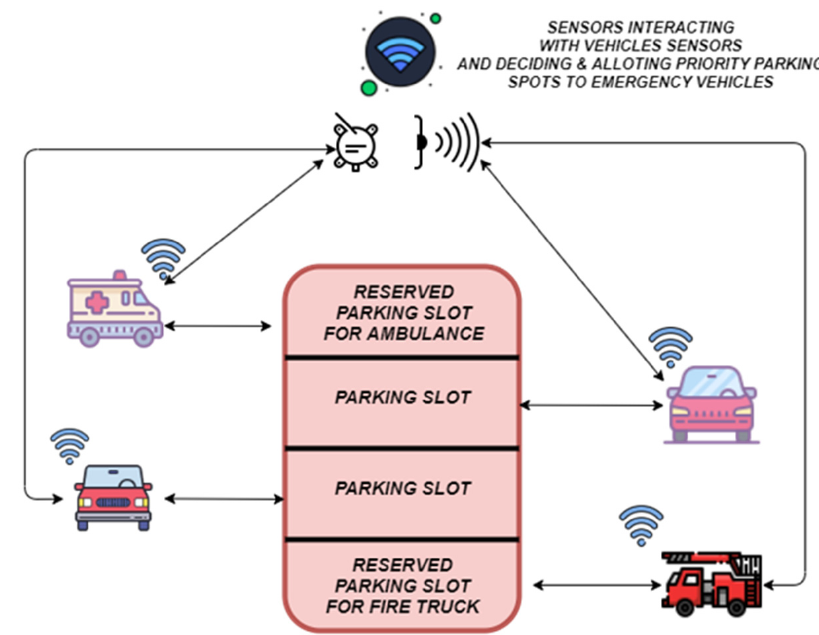
Figure 6. Emergency vehicle assistance.